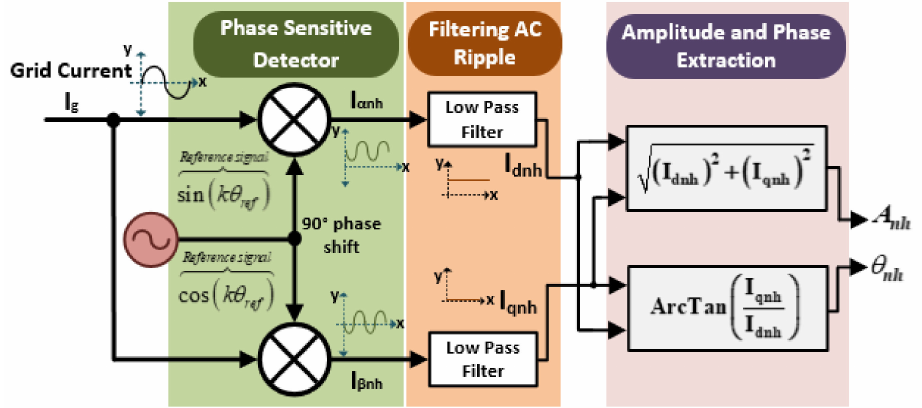
Figure 2. Block Diagram of a lock-in amplifier